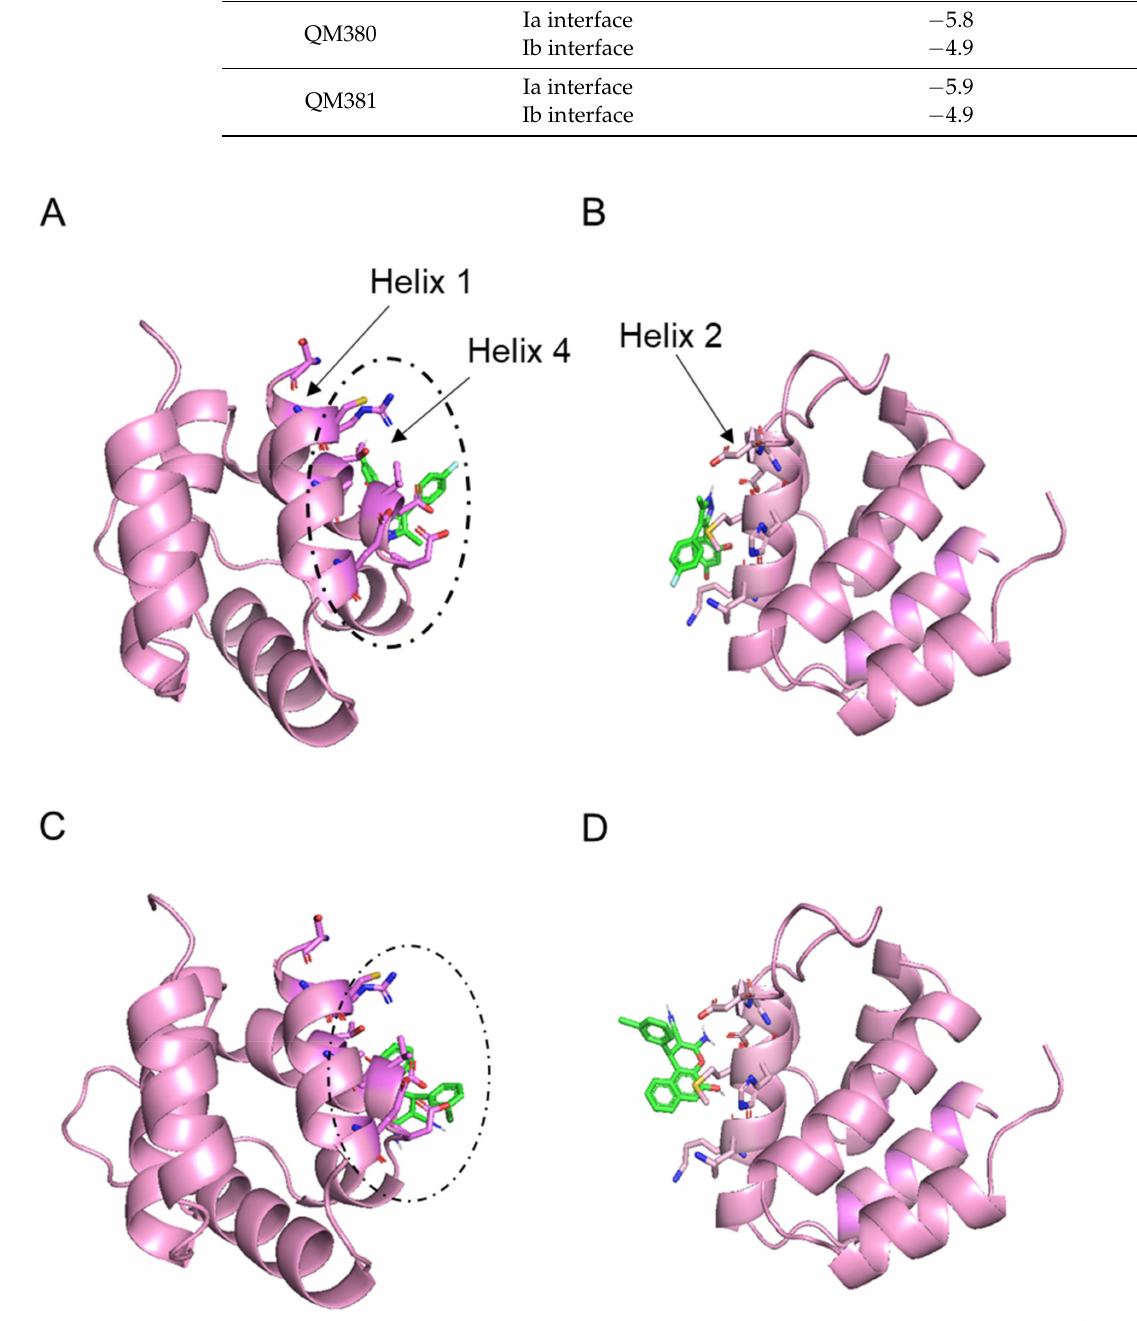
Figure 2. Graphical representation of docking study between NLRP3 PYD and ( A , B ) QM380, ( C , D ) QM381 (first poses) at the Ia ( A , C ) and Ib ( B , D ) interfaces, generated by Autodock Vina. In the peptide structures represented in cartoon form, residues that participated in the Ia (helices 1 and 4) and Ib (helix2) interfaces and ligands are in stick representation visualized by PYMOL